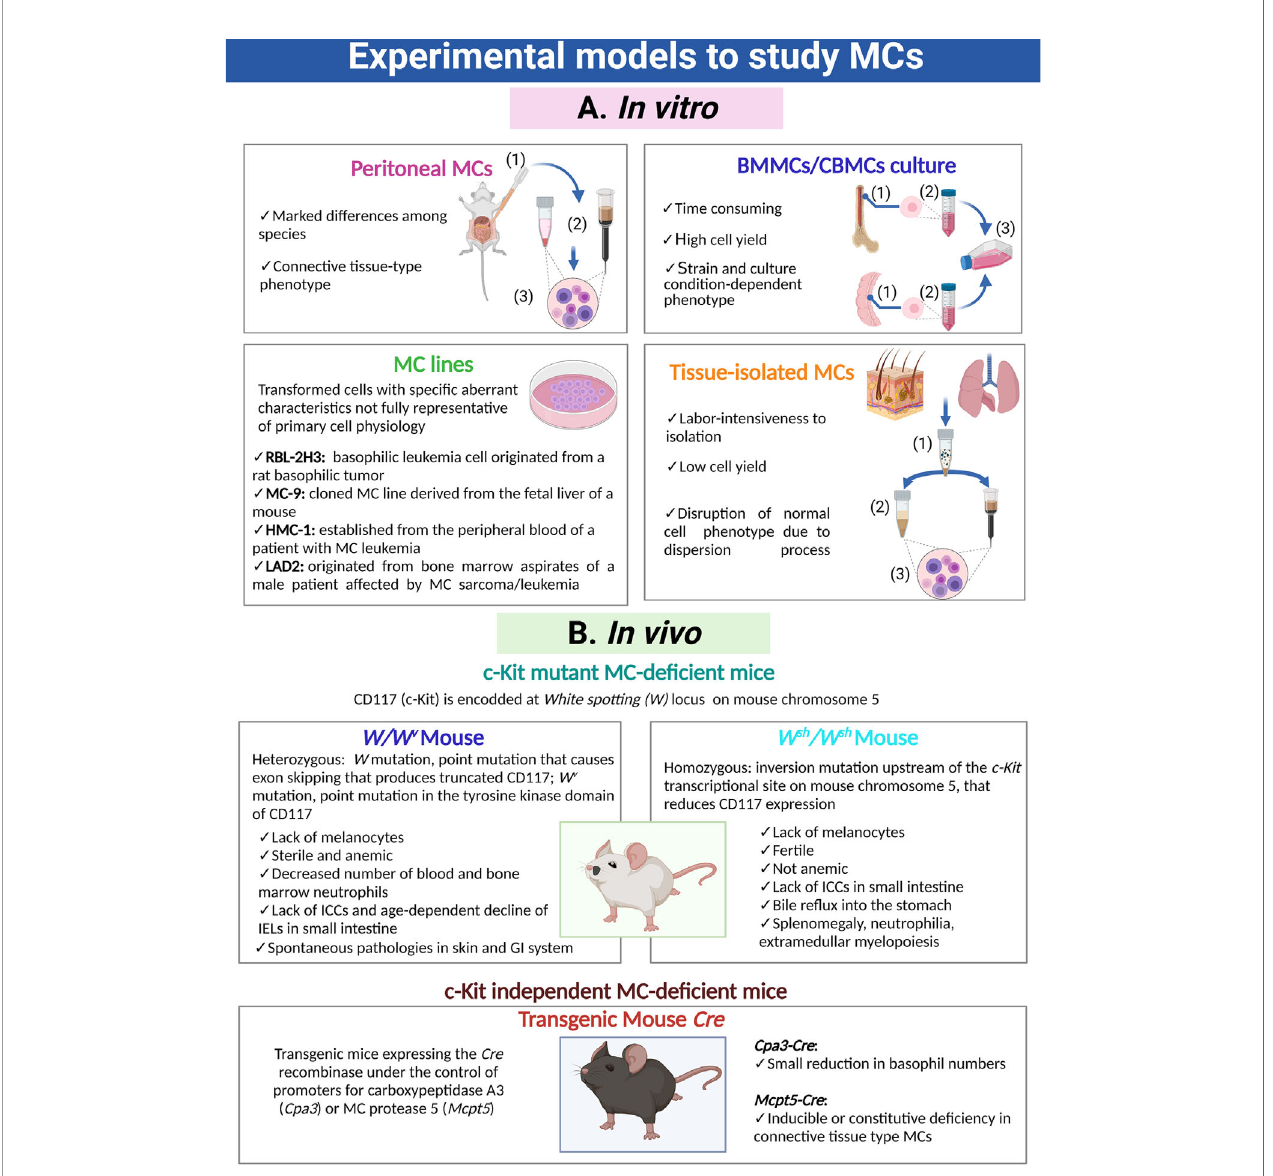
FIGURE 1 | Cellular and animal models utilized to investigate MCs. (A) Distinct MC preparations and cultures used for in vitro approaches. Puri fi cation of peritoneal MCs requires (1) peritoneal lavages, (2) puri fi cation through density gradients or magnetic beads coupled to speci fi c antibodies and (3) fi nal recovery of cells. Generation of bone marrow-derived MCs or cord blood-derived MCs requires (1) the isolation and disruption of the primary organ, (2) puri fi cation of immature precursors and (3) culture of those precursors for a prolonged period of time in the presence of speci fi c cytokines and growth factors. Isolation of tissue-resident MCs is a process that requires (1) fragmentation of the organ and gentle enzymatic digestion, (2) puri fi cation of MCs utilizing density gradients, cell sorting or magnetic beads coupled to speci fi c antibodies and (3) recovery of MCs. (B) Main animal models to analyze the role of MCs in vivo , indicating their phenotypic abnormalities. MC, mast cell; ICCs, interstitial cells of Cajal; IELs, intraepithelial lymphocytes TCR gd ; GI,